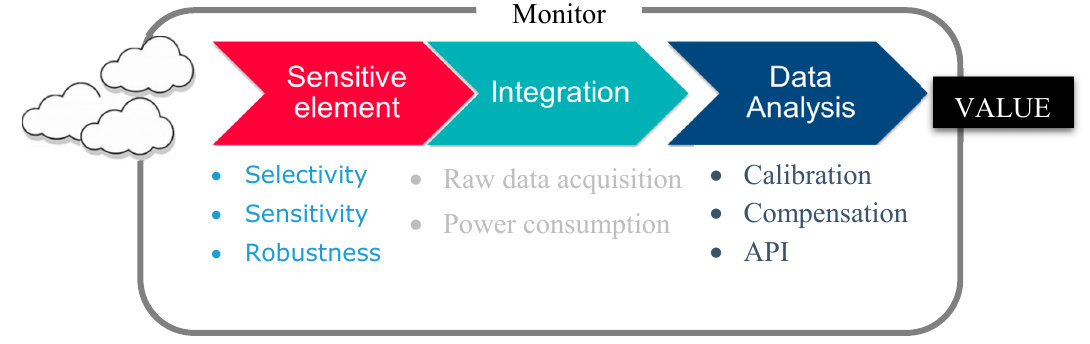
Figure 19. The process of how to get a concentration from a sensing device.